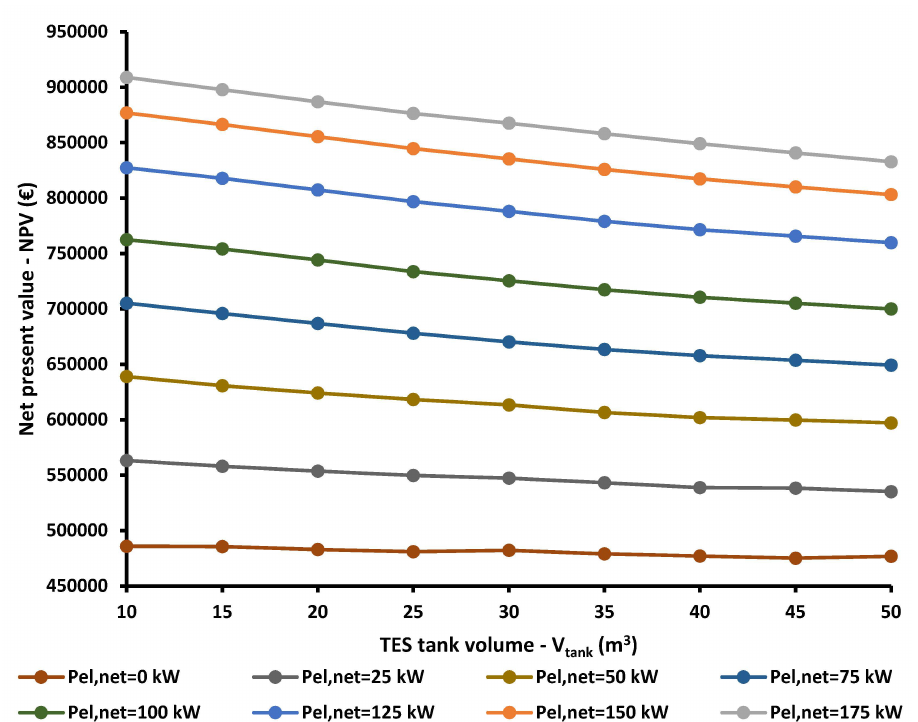
Figure 11. Net present value for different values of net electricity load and TES tank volume when the hydrogen price is equal to 15 EUR/kg.